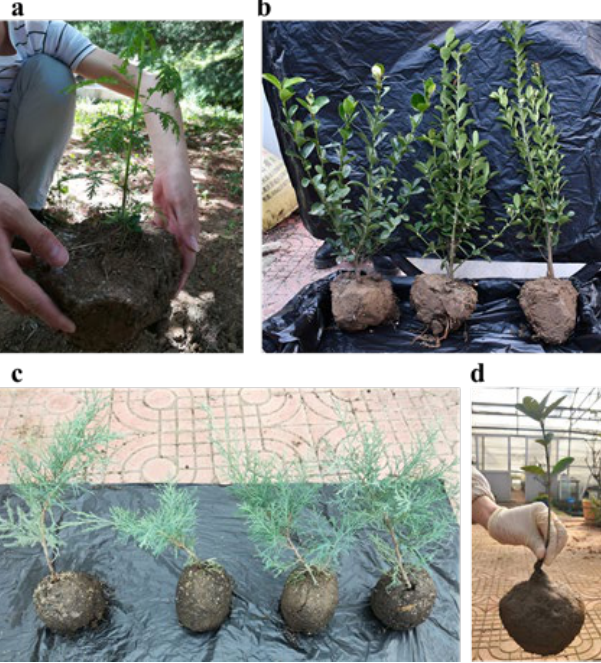
Figure 7. Preliminary application of KGM/CA/PVA ternary blend in seedling transplanting. ( a ) The diameter at breast height (DBH) of sierra salvia was 5 mm; ( b ) The DBH of Euonymus japonicas was 12 mm; ( c ) The DBH of Juniperus Sabina was 5 mm; ( d ) The DBH of Euonymus japonicas was 8 mm.